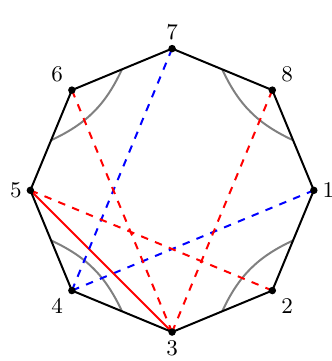
Figure 8 . The set F for α = [(1 , 2) , (3 , 4) , (5 , 6) , (7 , 8)] . The shifted propagator X 3 , 5 is represented by a red solid line and the other elements in F (1) are given in red dashed lines. The elements of F (2) are shown with blue dashed